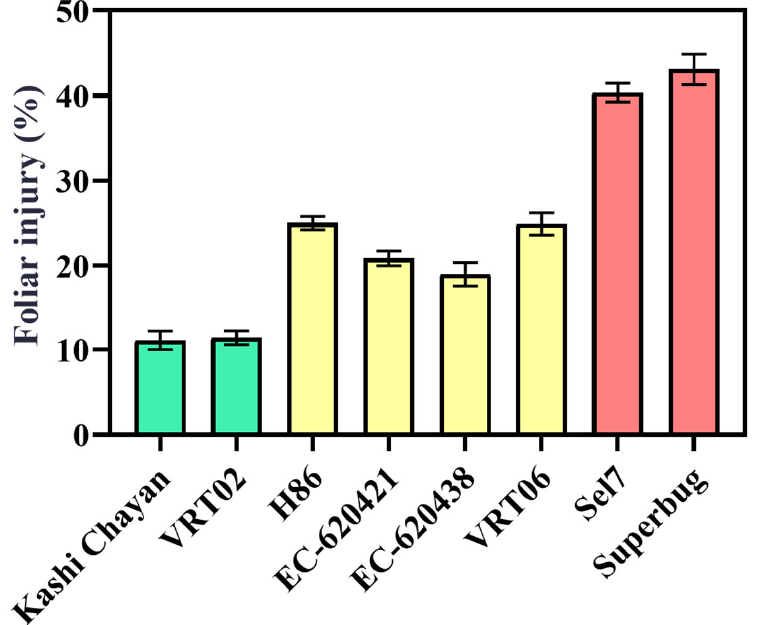
Figure 2. Percentage of foliar O 3 injury in tomato cultivars under elevated O 3 at 75 DAG. The bars designate the O 3 injury with different color codes representing the severity of the foliar injury; green color—slight injury, yellow color—moderate injury, and red color—severe injury.